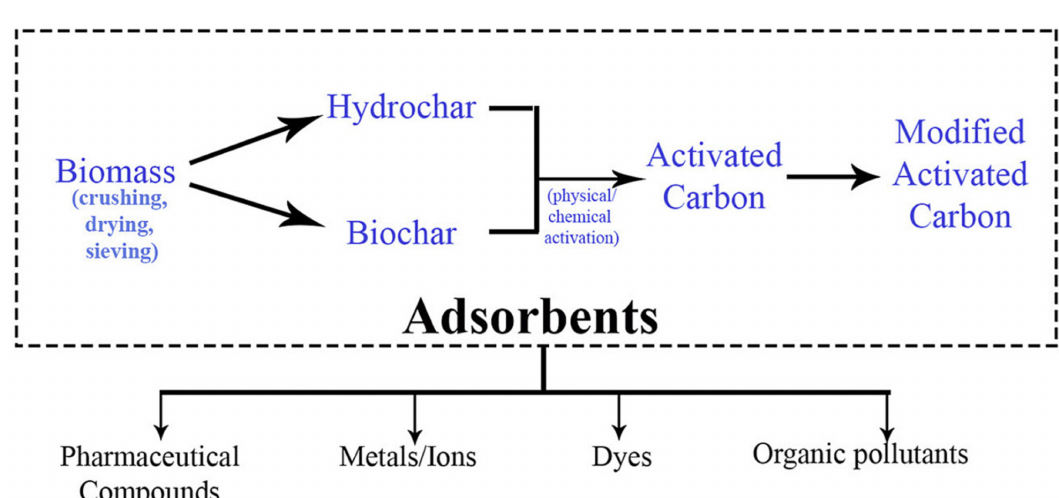
Figure 14. Synthesis routes of activated carbons from